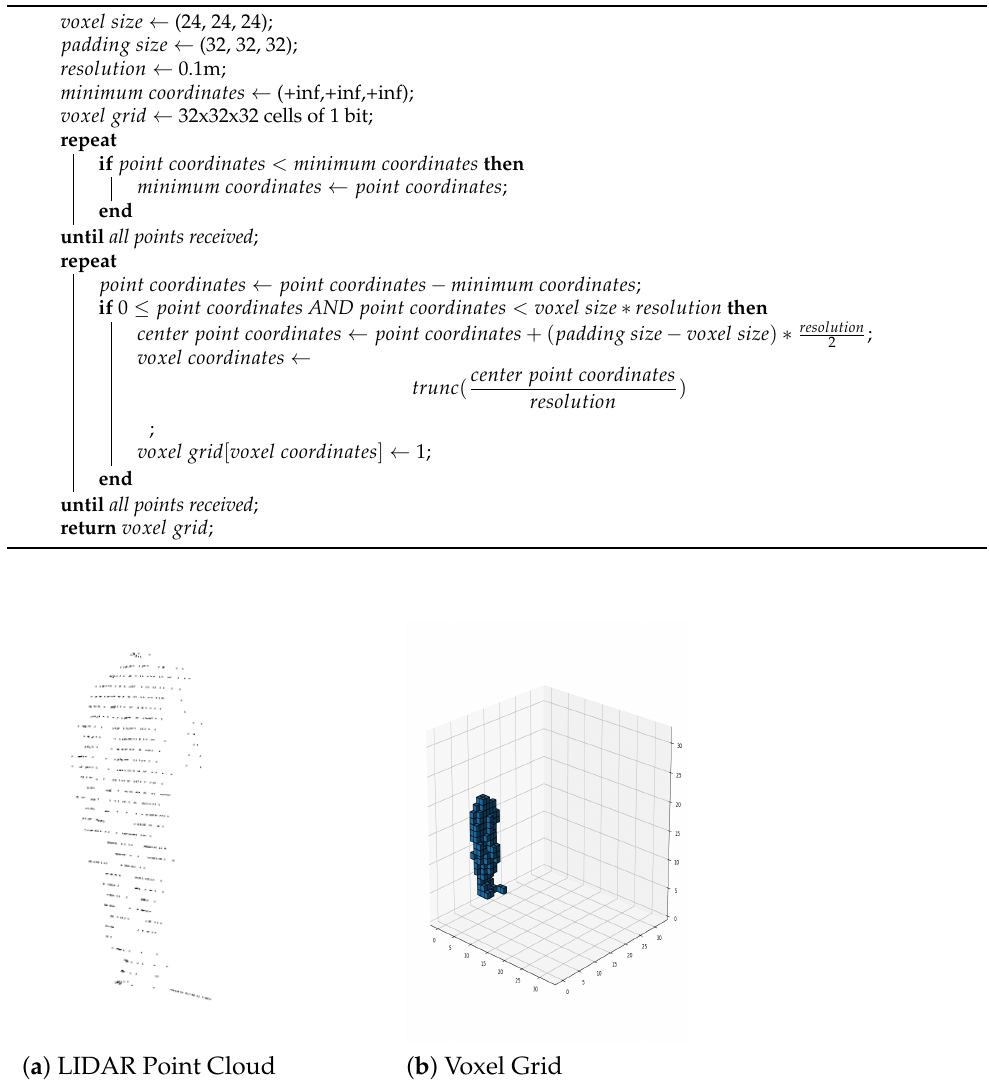
Figure 10. Pedestrian extracted from a box: ( a ) Pedestrian as a LIDAR Point Cloud, ( b ) Pedestrian as a Voxel